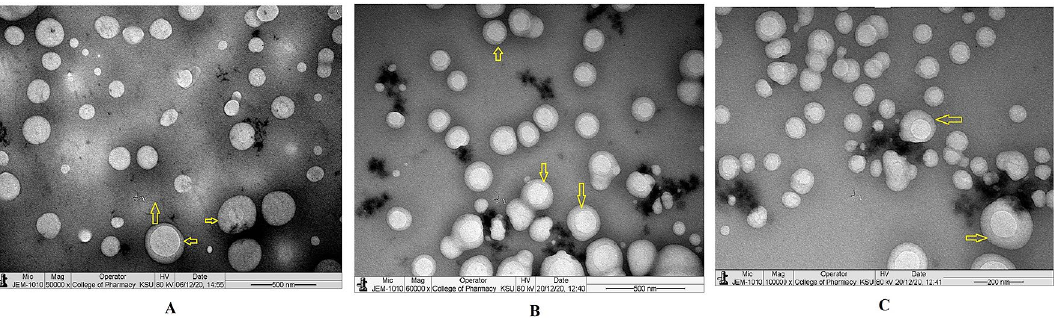
Figure 7. Transmission electron microscope study. ( A ) Morphology of injectable mAbCCNP colloidal solution under ×50,000 magnification. ( B ) Morphology of injectable mAbCCNP colloidal solution under ×60,000 magnification ( C ) Morphology of injectable mAbCCNP colloidal solution under ×100,000 magnification. The yellow colour aero marks of all the three photographs indicating clear zone around the nanoparticle that represents rituximab attachment on CCNP.